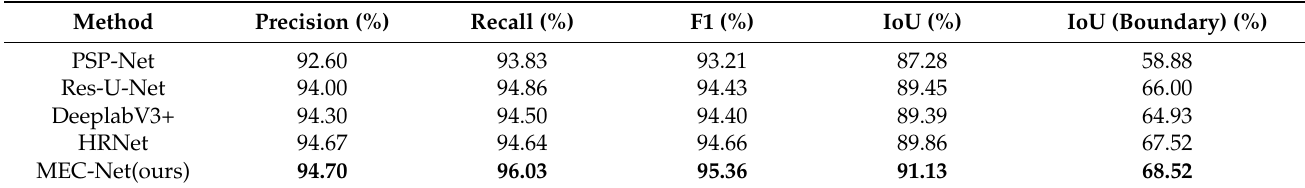
Table 2. Quantitative evaluation of MEC-Net using the WHU dataset.